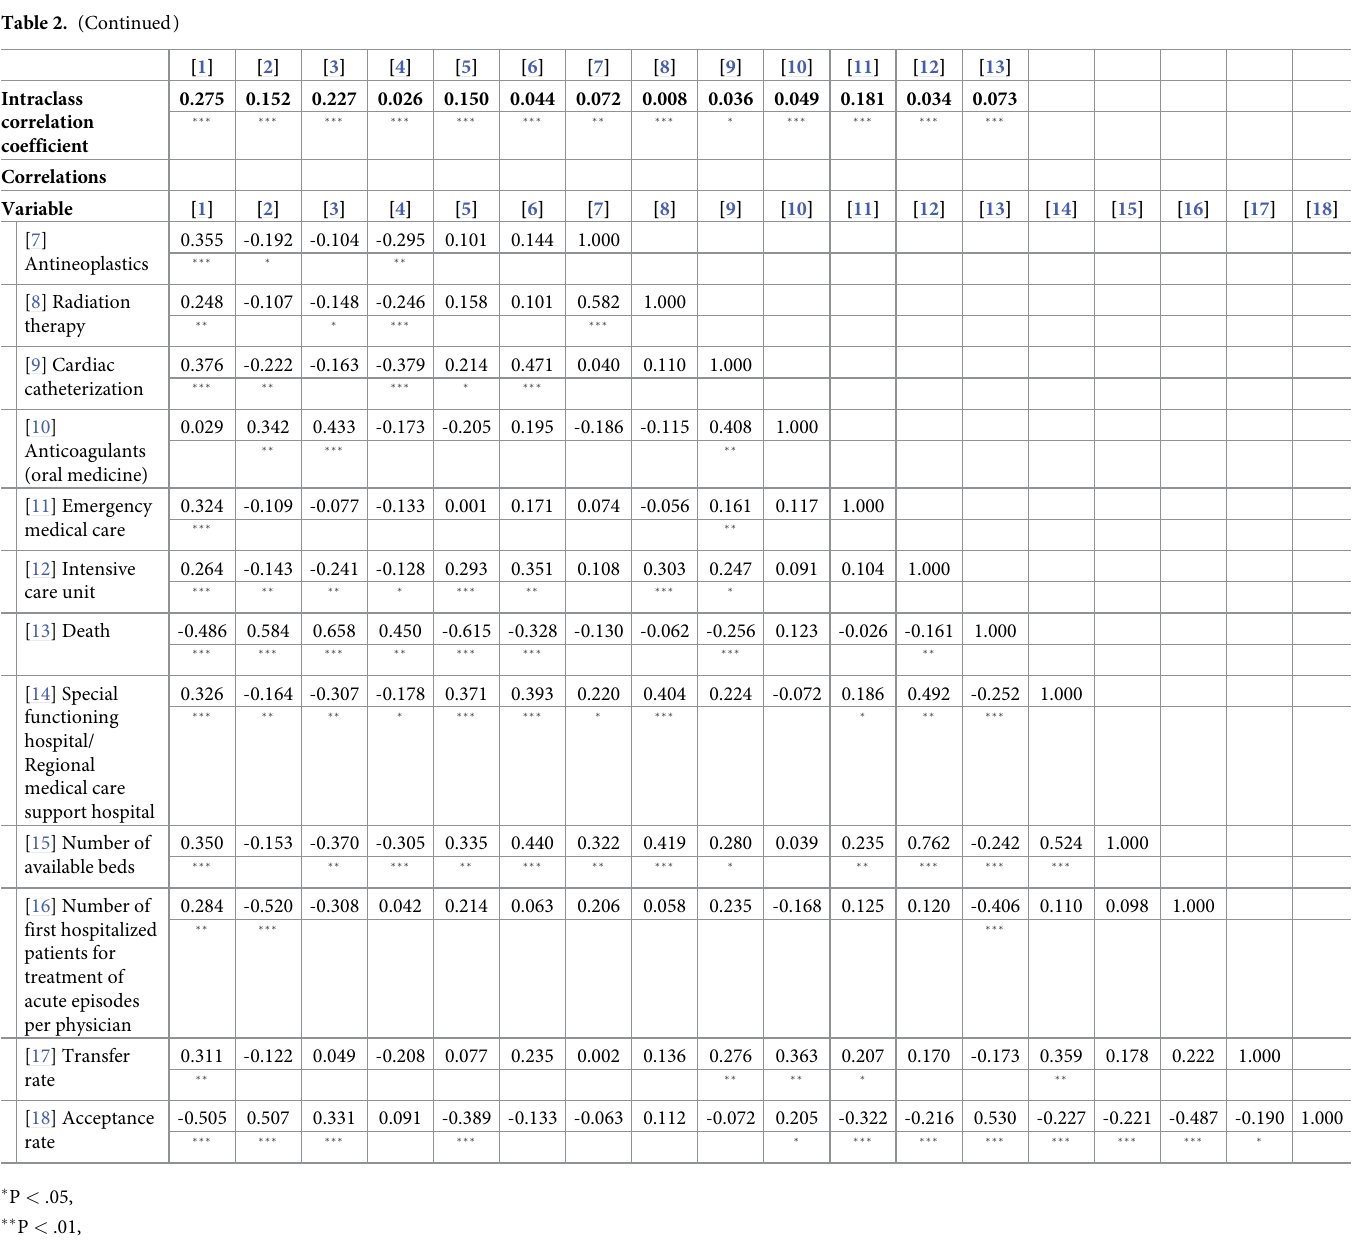
rate, number of available beds, and special functioning hospital/regional medical care support hospital. There was no significant effect of death on medical service fees per day or LOS. In the within model, LOS had a significant negative association with increased medical ser- vice fees per day. All patient characteristics and medical activities had significant direct effects and were positively associated with increased medical service fees per day. Age, emergency medical care, and surgery had reduced total positive effects due to significant indirect negative effects of prolonged